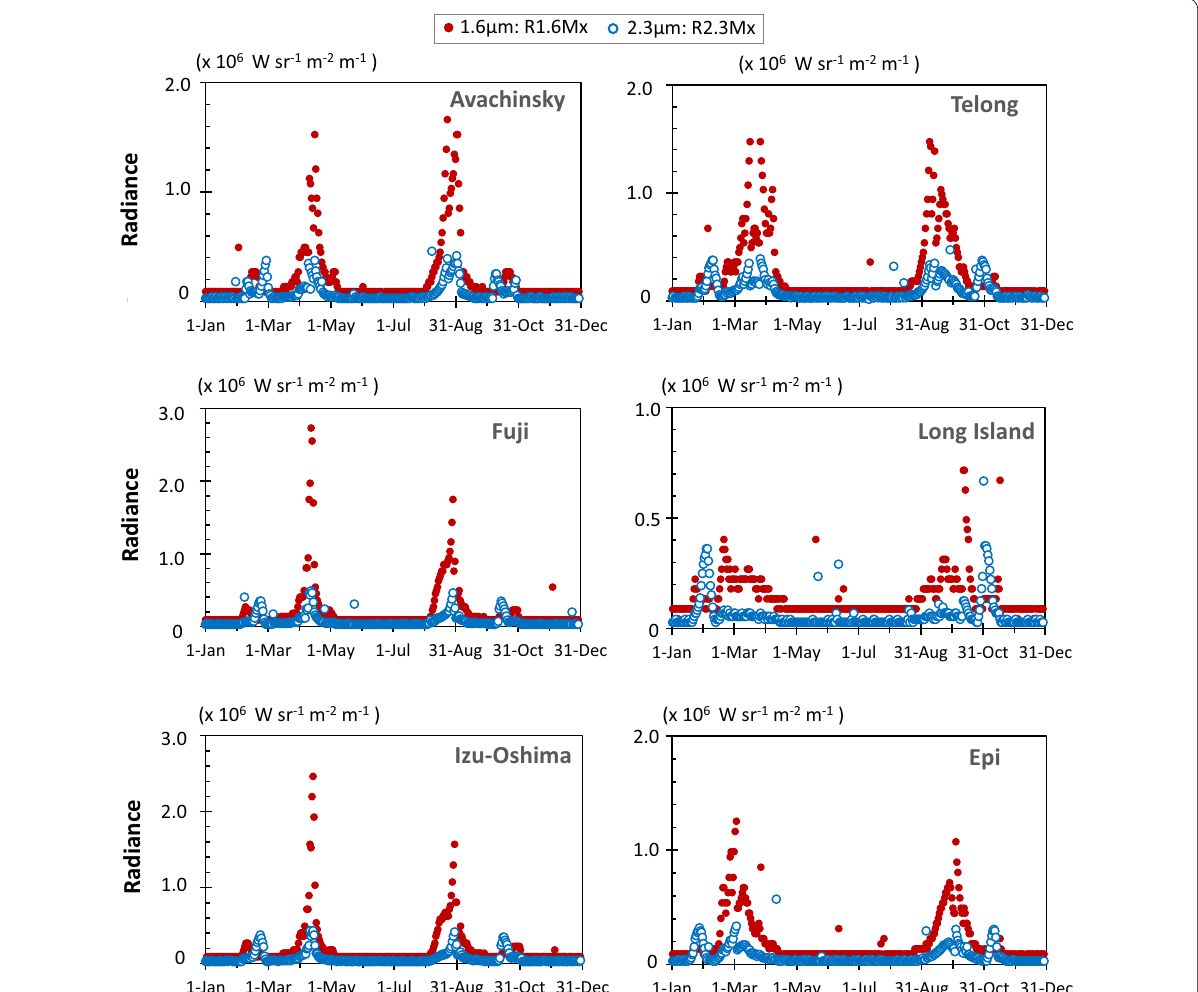
Fig. 1 Annual variation of the pseudo-thermal anomaly in the nighttime 1.6-µm and 2.3-µm images